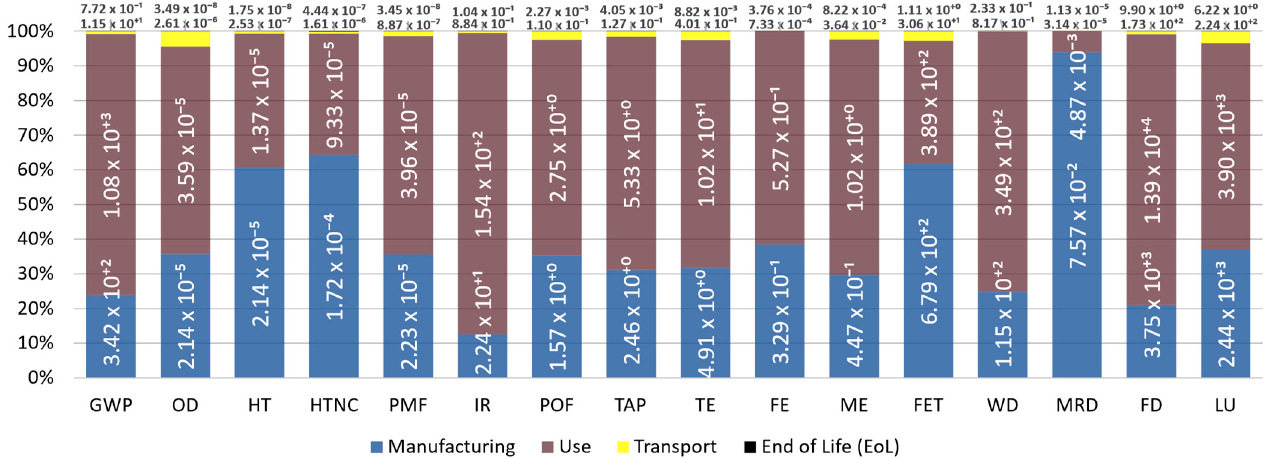
Figure 3. LCA results of an inverter operating point for a 150 kW load from a DC power source of 450 V, based on 15 years and 10,000 operating hours. This output conveys the standardized environmental impacts, according to the European Commission [27]. All abbreviations are presented in Table 1.